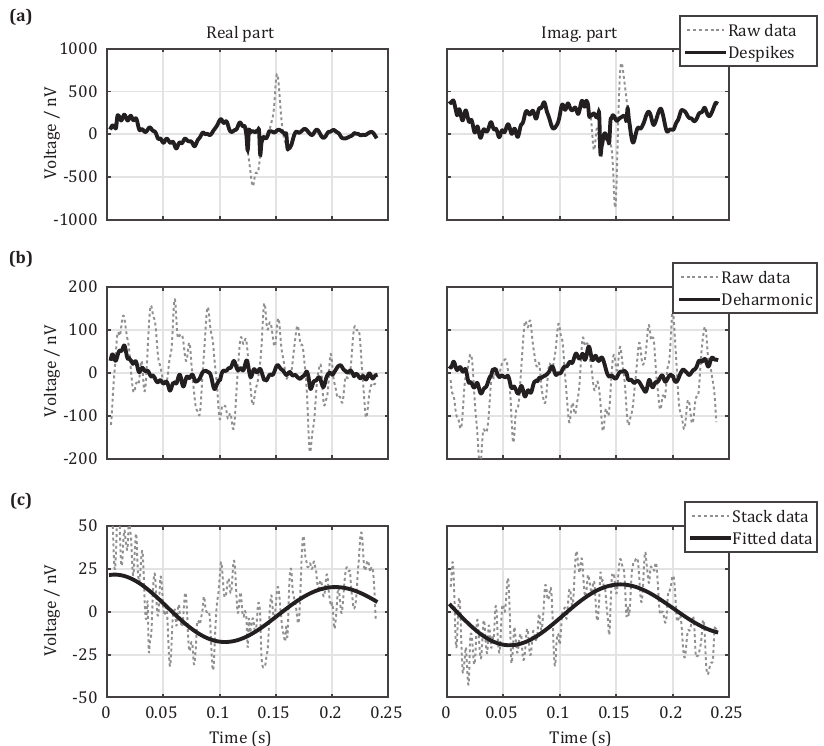
Figure 8. Data processing flow of measured UMRS signal. ( a ) Real and imaginary parts of the measured UMRS signal before and after eliminating spiky noises; ( b ) real and imaginary parts of the UMRS signal after cancelling power-line harmonics; ( c ) real and imaginary parts of the stacked UMRS signal and the fitted